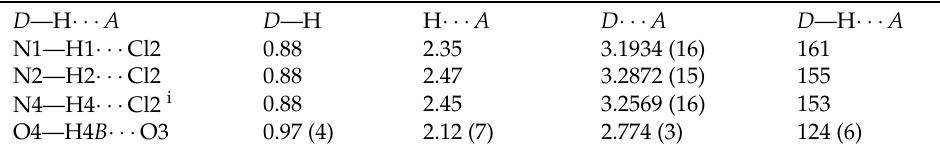
Table 3. Hydrogen-bond geometry (Å, º) for (II).